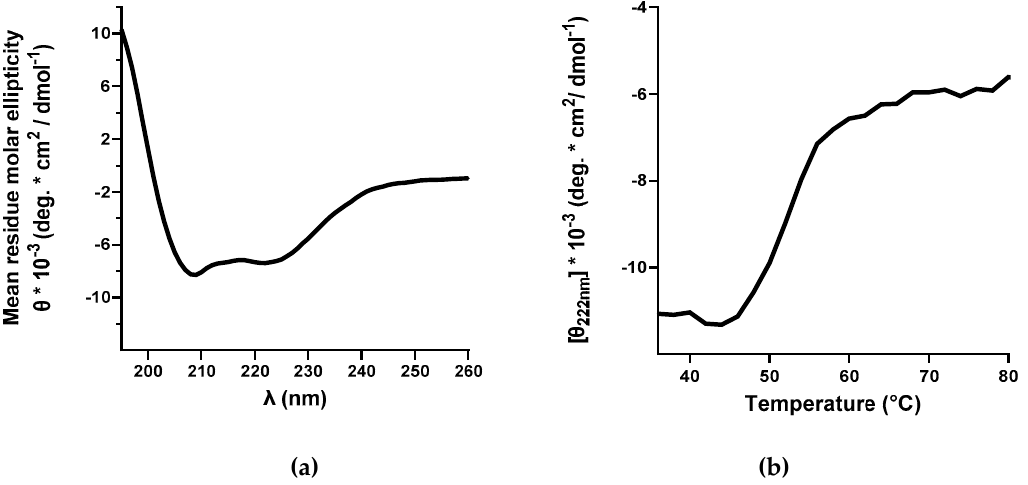
Figure 3. Far-UV circular dichroism analysis of rhCNTF. ( a ) Analysis of rhCNTF secondary structure at 25°C: characteristic maximum around 195 nm with minima at 208 and 220 nm point to a highly helical protein, reflecting the correct α -helical secondary structure and folding of purified rhCNTF. ( b ) Thermal denaturation of rhCNTF observed as changes in ellipticity at 222 nm, reporting α -helical unfolding.